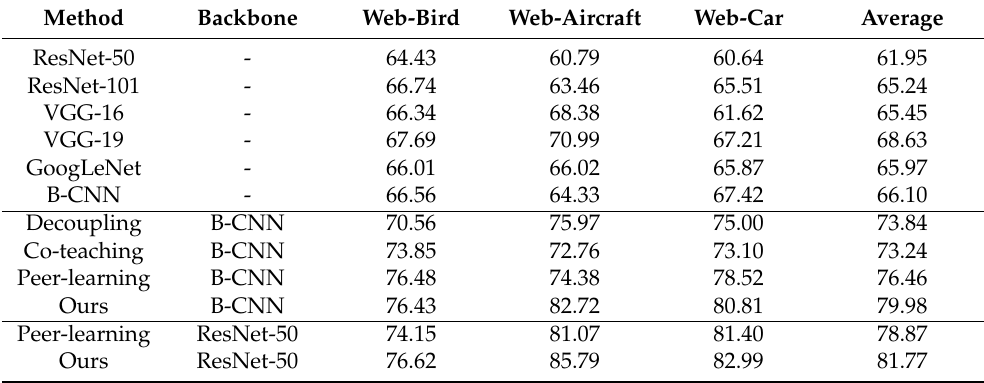
Table 2. Comparison of recognition accuracy(%) of different models on three datasets.